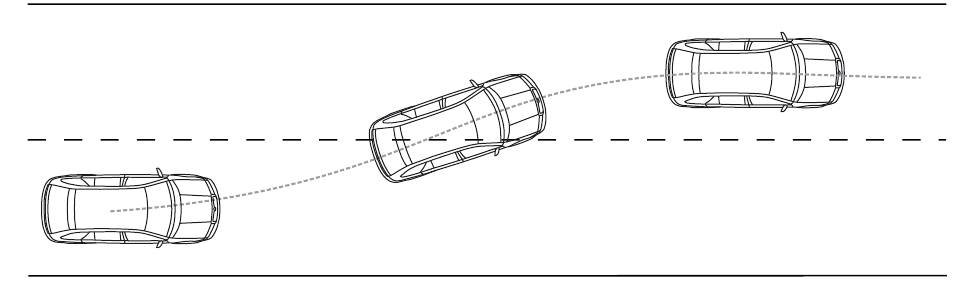
Figure 1. Lane change